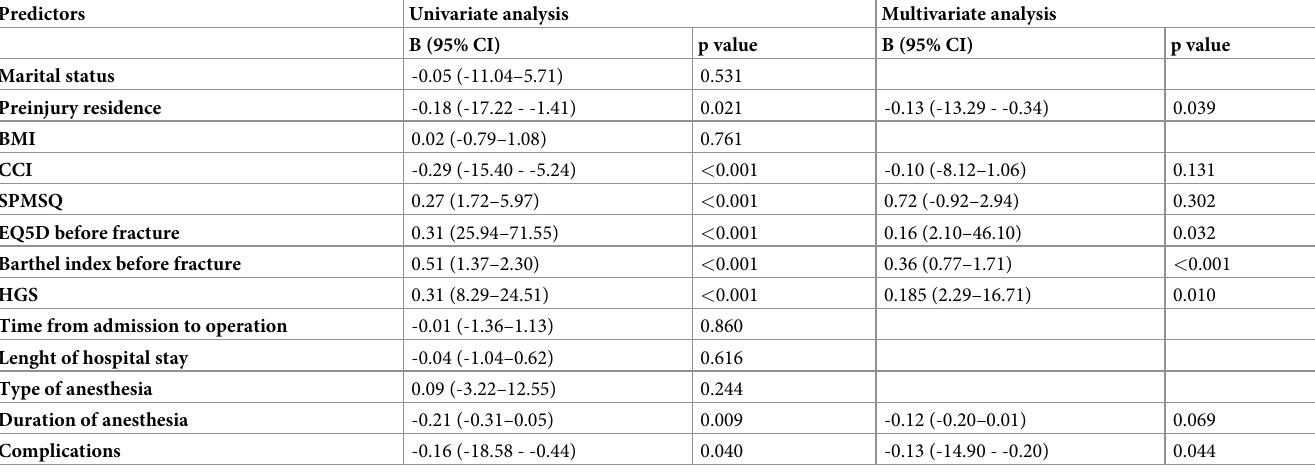
Table 2. Univariate and multivariate analysis for variables significantly associated with Barthel index scores 3 months after fracture.